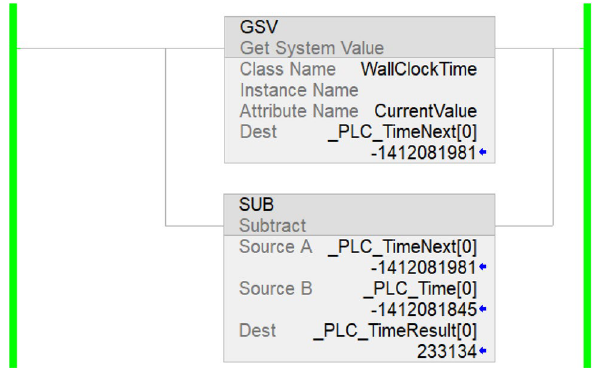
Fig. 20 Preventing further logic scanning